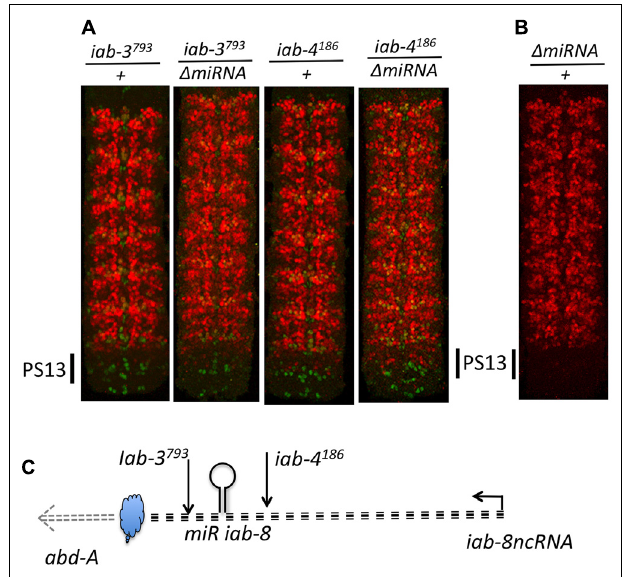
FIGURE 10 | Haplo-insufficiency of breaks disrupting the iab-8 ncRNA. Panel A show CNSs stained for abd-A (red) and engrailed (green) from embryos heterozygous for mutations disrupting the iab-8ncRNA. Panel B dispalys a CNS from a heterozygous Δ miRNA/ + embryo. Note that while one dose of miR-iab-8 is sufficient to keep abd-A repressed in PS13 (B) , de-repression of abd-A in PS13 is observed in each of the four genotypes displayed in panel A . Panel C summarizes the relative positions of the trans -acting repression mechanism (miRiab-8) and cis -acting repression mechanism symbolized as a cloud.The level of de-repressions depends on the position of the disrupting break (upstream or downstream of miRiab-8). De-repression increases when the disrupting break is over Δ miRNA. In iab-4 186 / Δ miRNA PS13 abd-A expression reaches a level as if only one of the two homologs produces